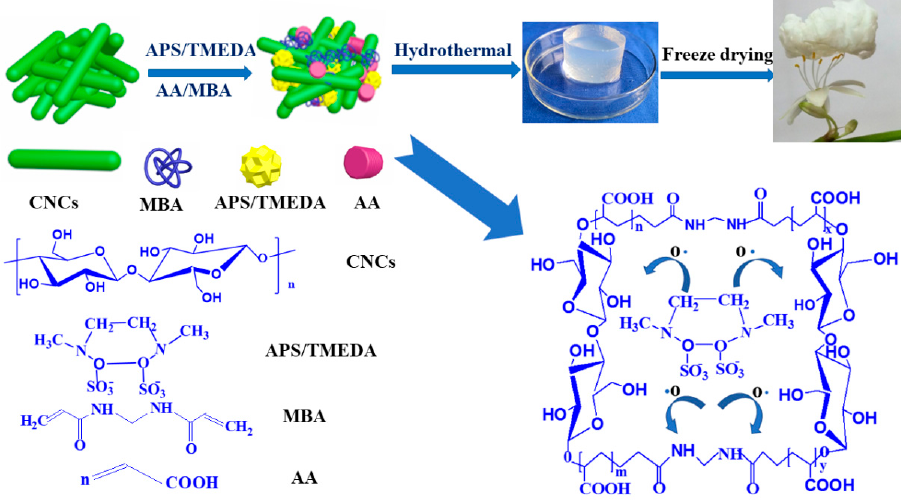
Figure 5. Mechanistic diagram of CNC-g-AA aerogel formation.